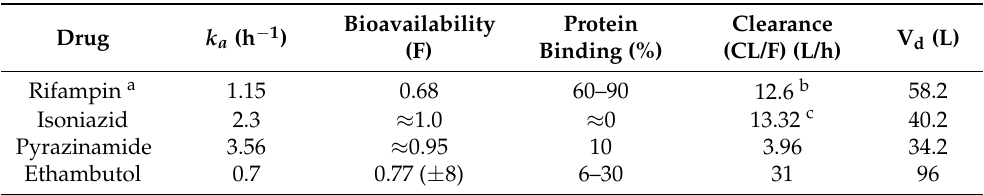
Table 2. Primary pharmacokinetic parameter estimates for antimycobacterial drugs in adult patients with non-sepsis tuberculous disease. Source: data extracted from